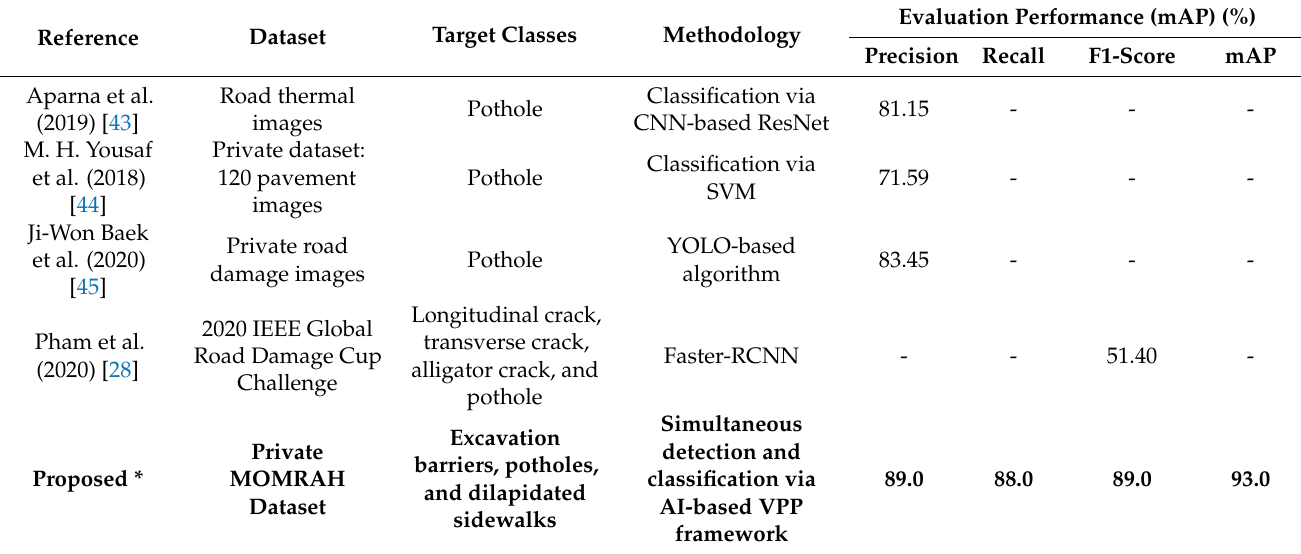
Table 4. Comparison evaluation results of the proposed VPP framework against the latest works available in the